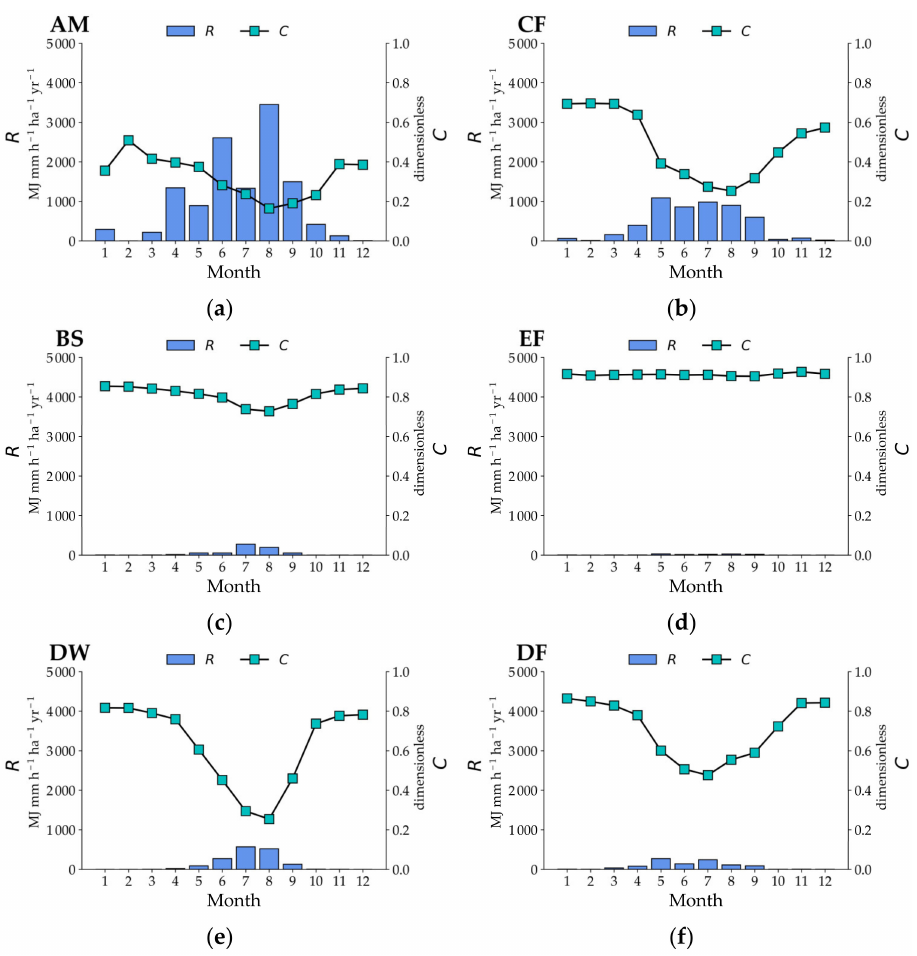
Figure 5. Monthly changes of R and C values. ( a ) AM, ( b ) CF, ( c ) BS, ( d ) EF, ( e ) DW, ( f )